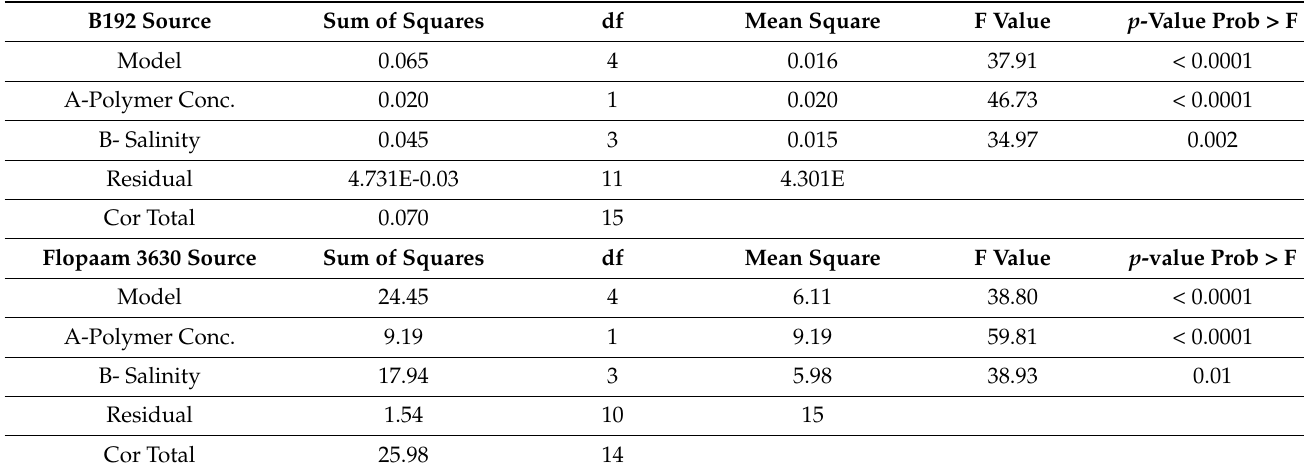
Table 5. Results of ANOVA for shear viscosity of B192 and Flopaam